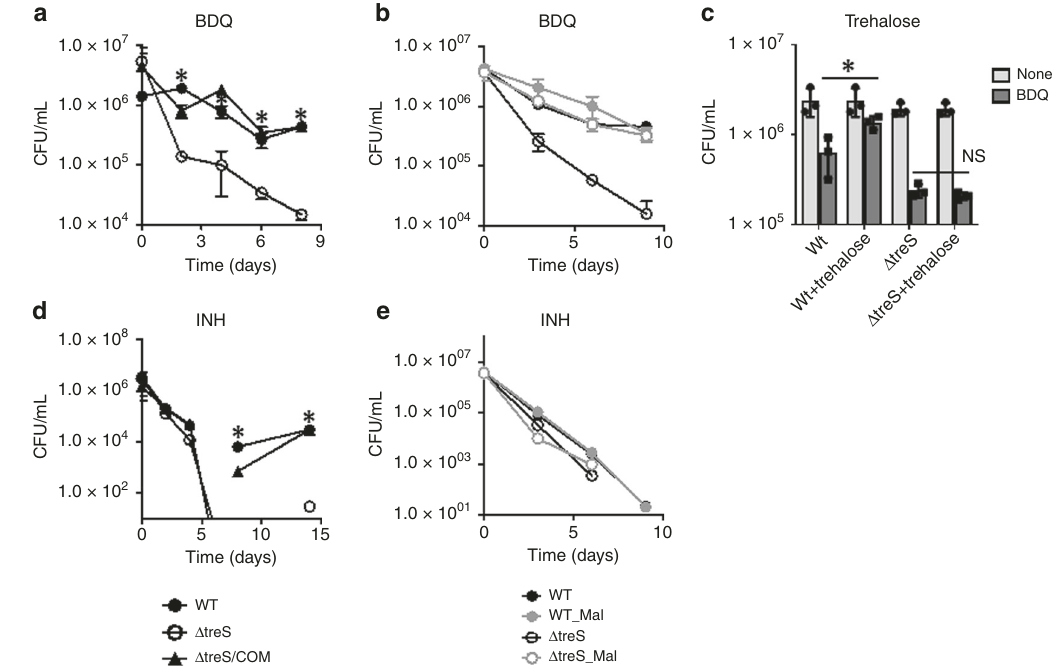
Fig. 4 The trehalose-catalytic shift is used to circumvent BDQ and INH effects. a CFU (colony-forming unit) viability of WT Mtb, Δ treS, and Δ treS/com following treatment with 10× MIC-equivalent BDQ. The effect of supplementing with b 20 mM maltose and c trehalose on WT Mtb Δ treS, and Δ treS/com CFU viability following treatment with 10× MIC-equivalent BDQ. d CFU viability of WT Mtb, Δ treS, and Δ treS/com following treatment with 10× MIC- equivalent INH. e The effect of supplementation of 20 mM maltose on CFU viability of WT Mtb, Δ treS, and Δ treS/com with co-treatment of 10× MIC- equivalent INH. All values are the average of experimental triplicates ±s.e.m. and representative of at least two independent experiments. * P < 0.01. NS, not signi fi cant by Student ’ s unpaired t